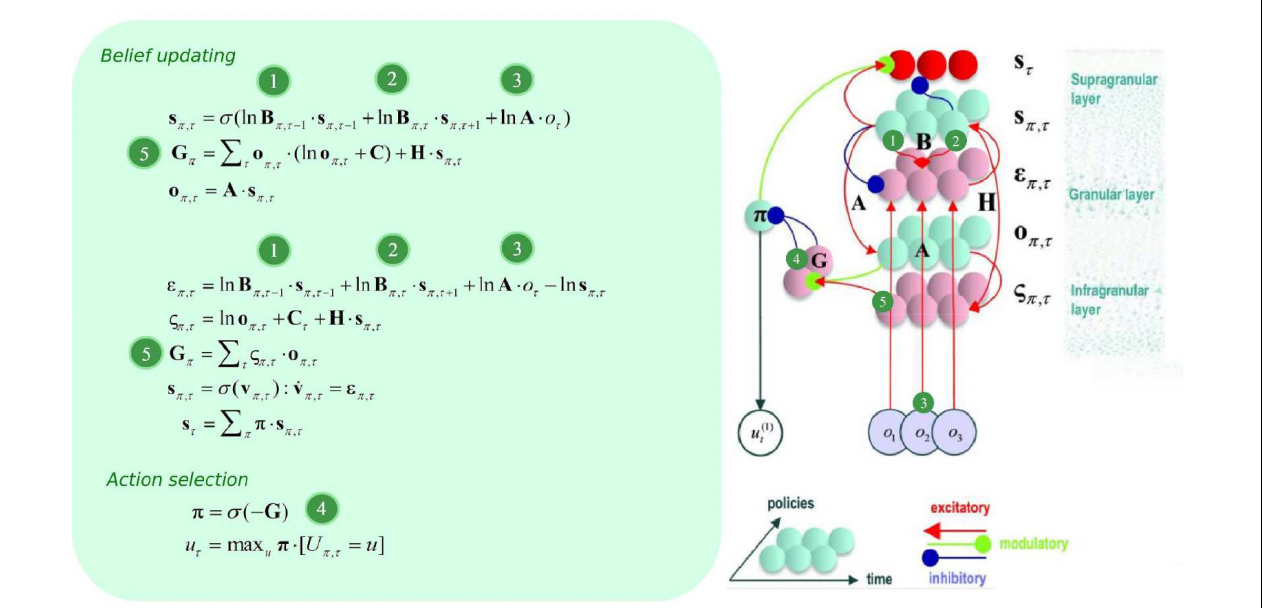
FIGURE 2 | Belief update and propagation. The left panel shows the equations that underlie (approximate Bayesian) inference and action selection. The differential equations (middle left) can be construed as a gradient descent on (variational) free energy, and are defined in terms of prediction errors. Policy expectations are computed by combining the two types of prediction error ( state and outcome ), via a softmax function (message 4). State PE quantifies the difference between expected states for each policy (messages 1, 2, and 3), whereas outcome PE computes the difference between expected and predicted outcomes, and is weighted by the expected outcomes to estimate the expected free energy (message 5). The right panel displays the message passing implied by the belief update equations in the left panel. Neural populations are represented by the colored spheres, which are organized to reproduce recognized intrinsic connectivity for cortical areas. Red and blue arrows are excitatory and inhibitory, respectively. Green arrows are modulatory. Red spheres indicate Bayesian model averages, pink spheres indicate both types of PE. Cyan spheres represent expectations about hidden states and future outcomes for each policy. Connection strengths represent generative model